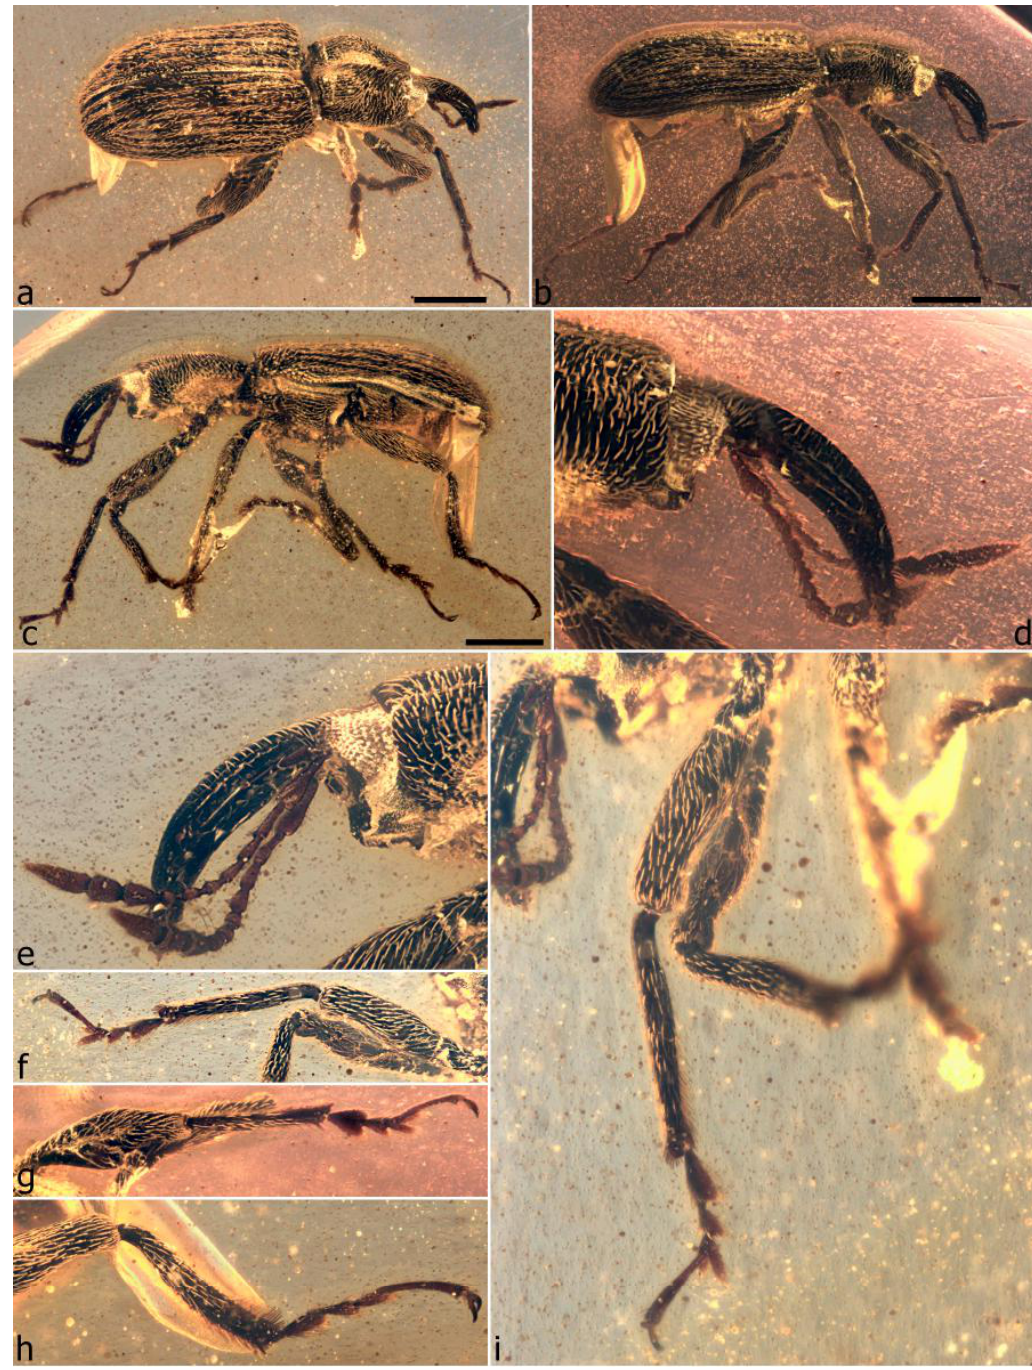
Figure 51. Burmorhinus setosus sp. n., holotype. Habitus, dorsolateral ( a ); habitus, right lateral ( b ); habitus, left lateral ( c ); head, antennae, and prothorax, right lateral ( d ); same, left lateral ( e ); forelegs, left ( f ); mesotibia ( g ); left metatibia ( h ); forelegs ( i ). Scale bars: 0.5 mm (a–c).